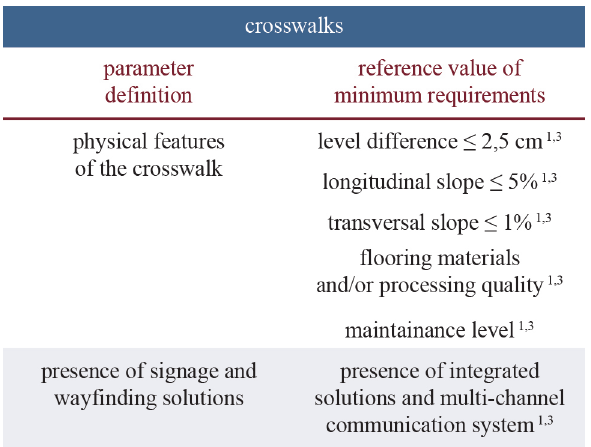
Table 4. Proposed parameters for the assess of crosswalks. Sources are 1: Italian regulation, 3: literature and empirical investigation.